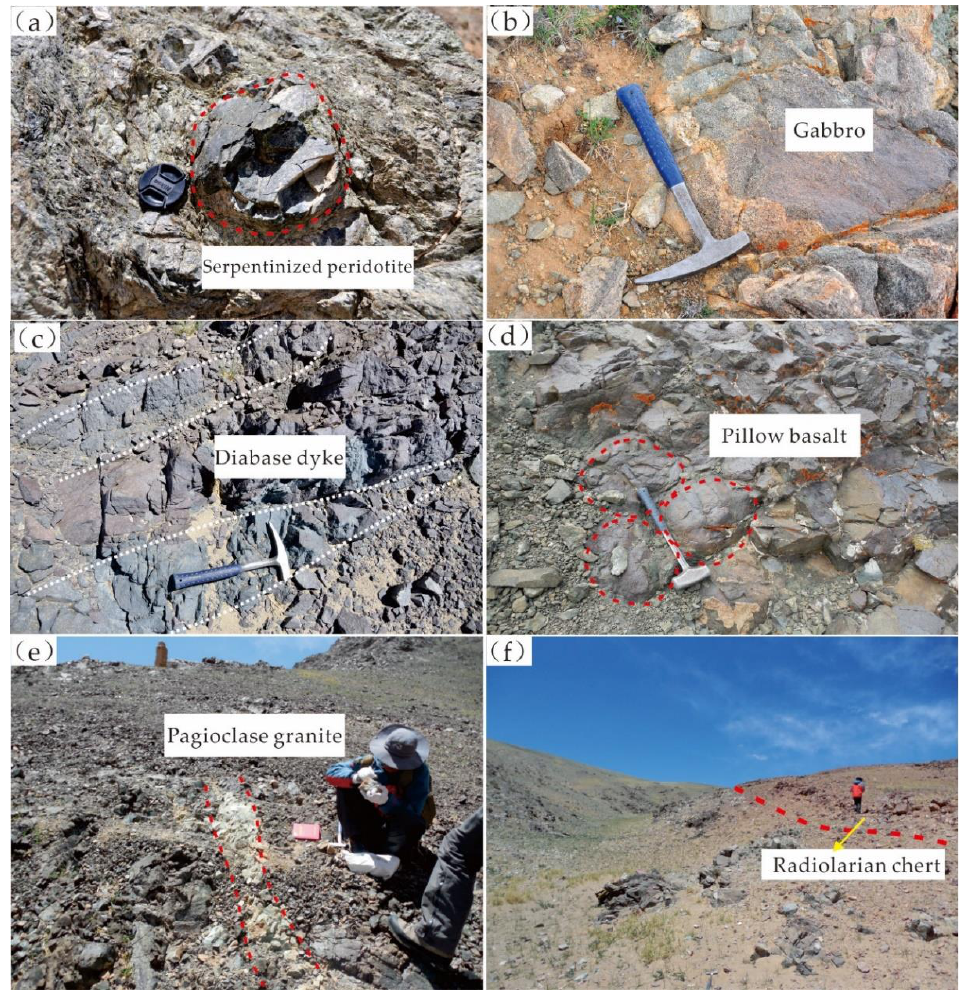
Figure 3. (a – f) Field photographs of the Laguoco ophiolite. ( a ) Serpentinzed peridotite; ( b ) Isotropic gabbro; ( c ) Diabase dyke; ( d ) Pillow basalt;( e ) Plagioclase granite; ( f ) Overlying radiolarian chert from Laguoco.